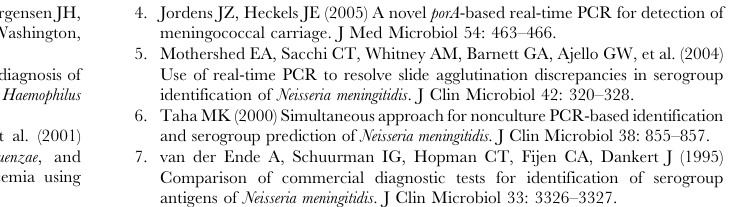
Table S1 Nm control isolates used for sodC assay design and optimization. Table S2 626 Nm isolates used to test the sensitivity of the sodC assay. Table S3 Nm sodC sequences generated in this study. Table S4 Two-by-two contingency tables that were the basis for the calculation of sodC PCR sensitivity and specificity compared to culture and ctrA PCR. (a) Comparison of sodC PCR to culture for 140 clinical specimens. (b) Comparison of sodC PCR to ctrA PCR for 157 clinical